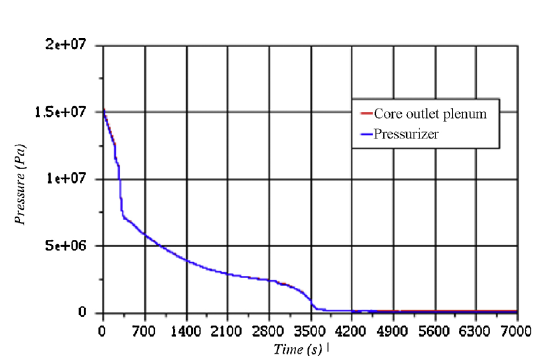
Fig. 20. Primary pressure